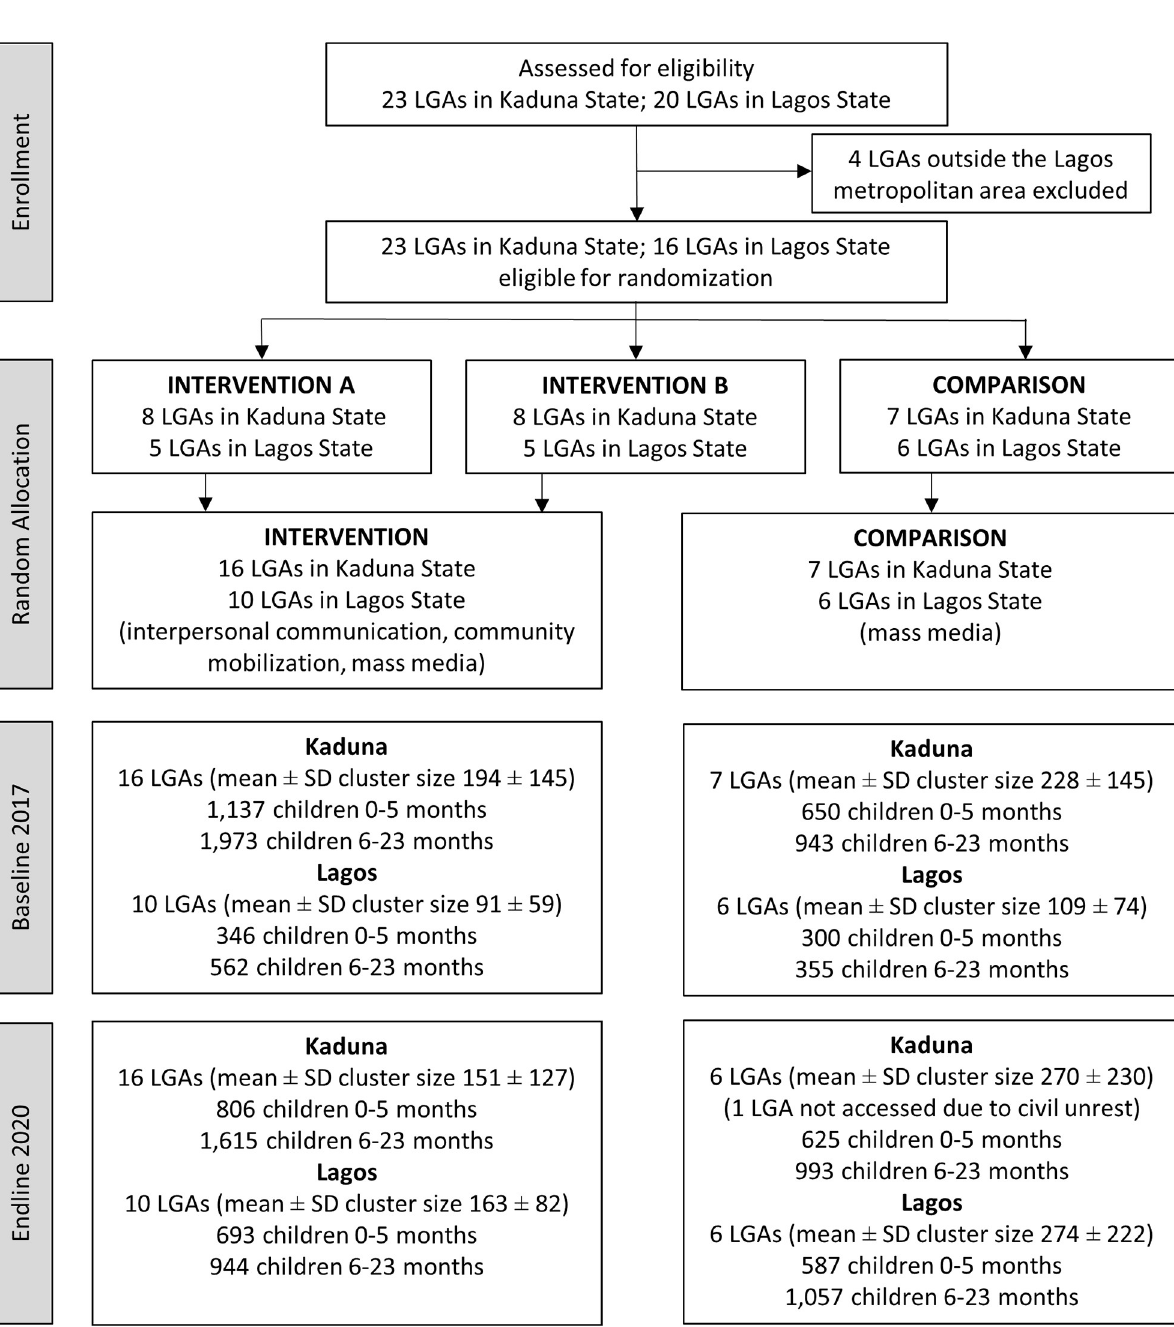
(unadjusted DDE -21.3 pp, P = 0.045; adjusted DDE -21.3 pp, P = 0.046) (Table 3). This effect resulted from a decrease in knowledge in the intervention group and an increase in the com- parison group from baseline to endline (intervention -16.0 pp, P = 0.024; comparison 5.4 pp, P = 0.473). No effects were detected on other knowledge variables because mothers’ knowledge of early initiation of breastfeeding increased in both study groups from baseline to endline